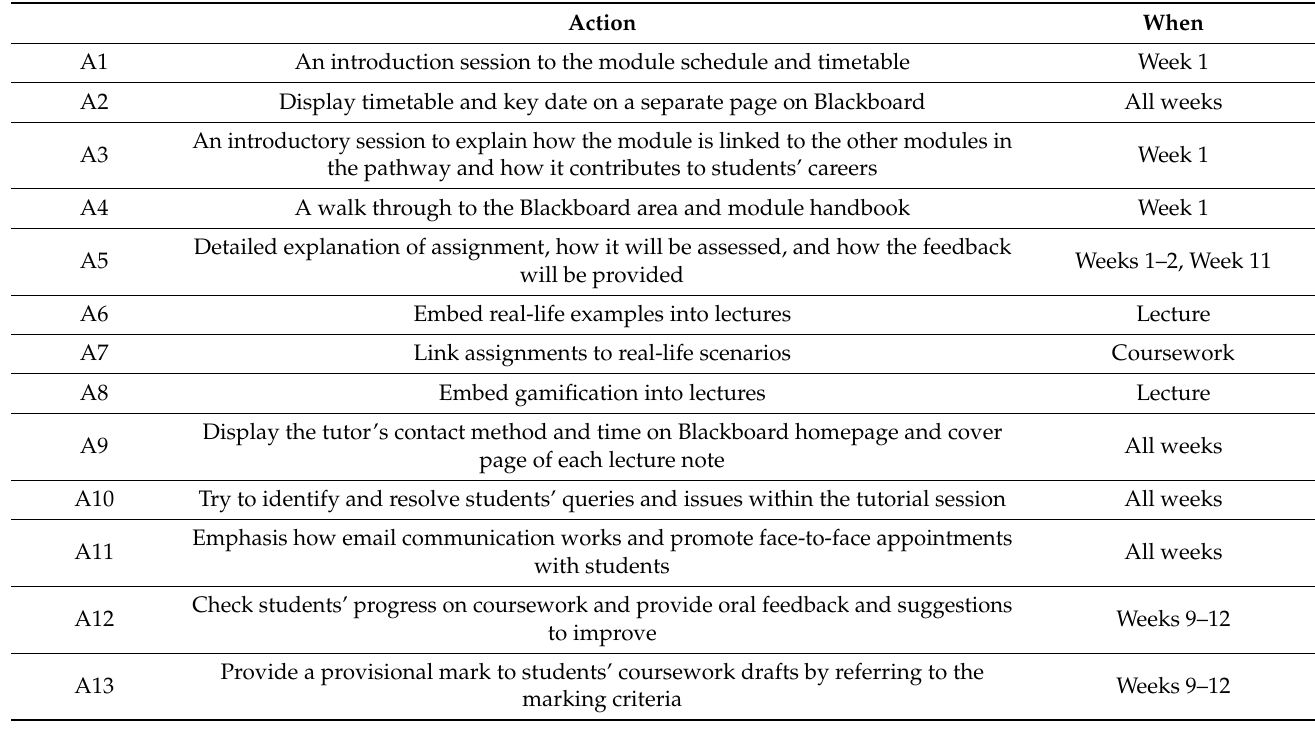
Table 2. Actions to improve student experience.